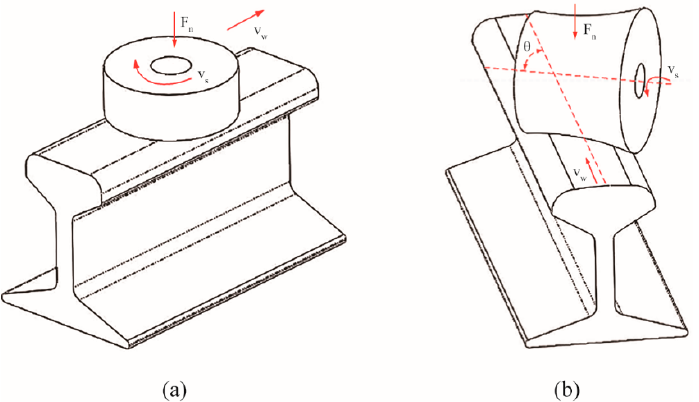
Figure 2. Schematic diagram of grinding process, ( a ) active grinding, ( b ) passive grinding.